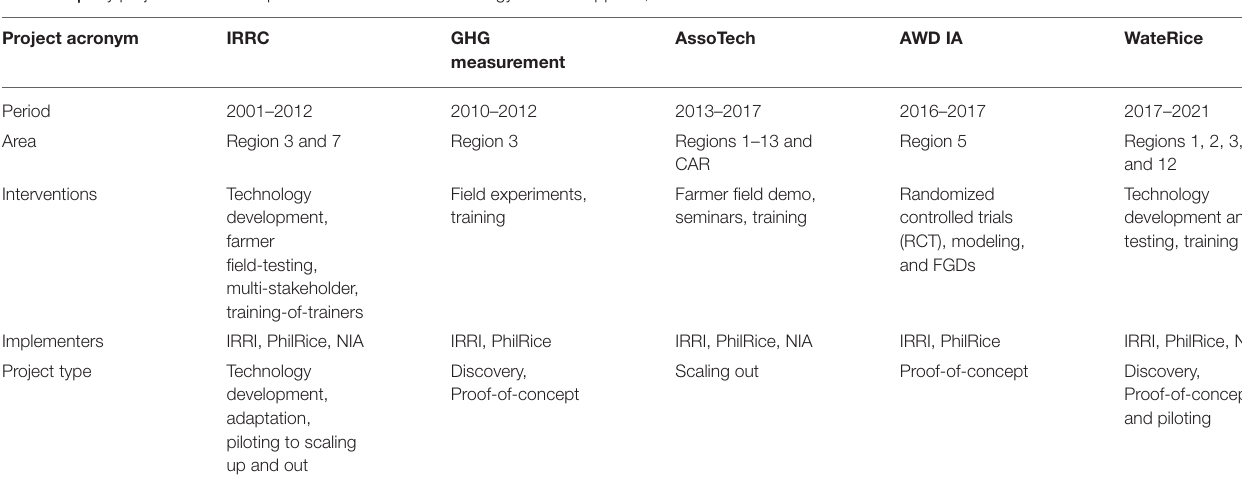
FIGURE 1 | Combined scaling up and innovation uncertainty framework (Adapted from: Cooley and Linn, 2014; Seelos and Mair, 2017) TABLE 1 | Key projects that developed and scaled AWD technology in the Philippines,